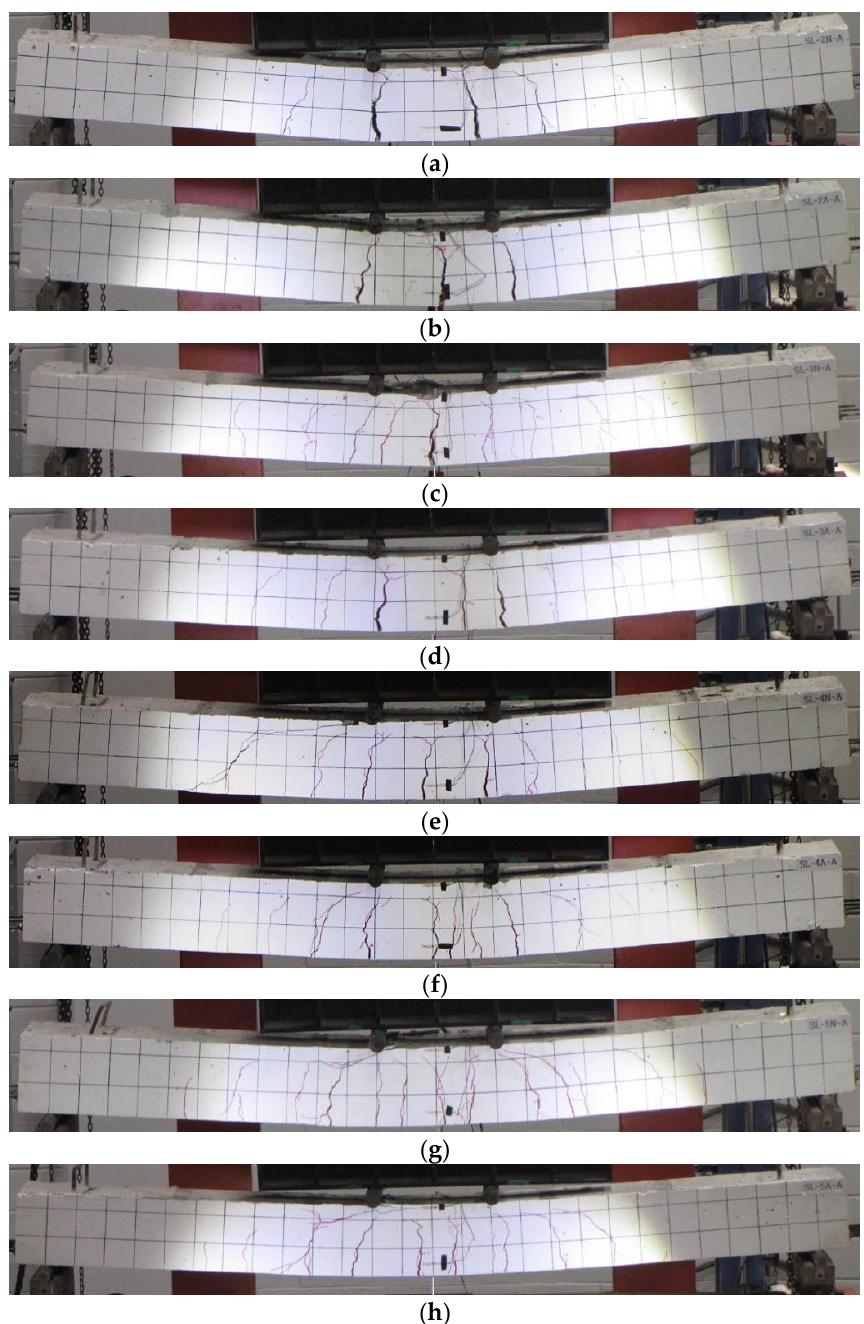
Figure 8. Failure modes of the specimens: ( a ) SL-2N, ( b ) SL-2A, ( c ) SL-3N, ( d ) SL-3A, ( e ) SL-4N, ( f ) SL-4A, ( g ) SL-5N, and ( h ) SL-5A. Table 3. Summary of test results.